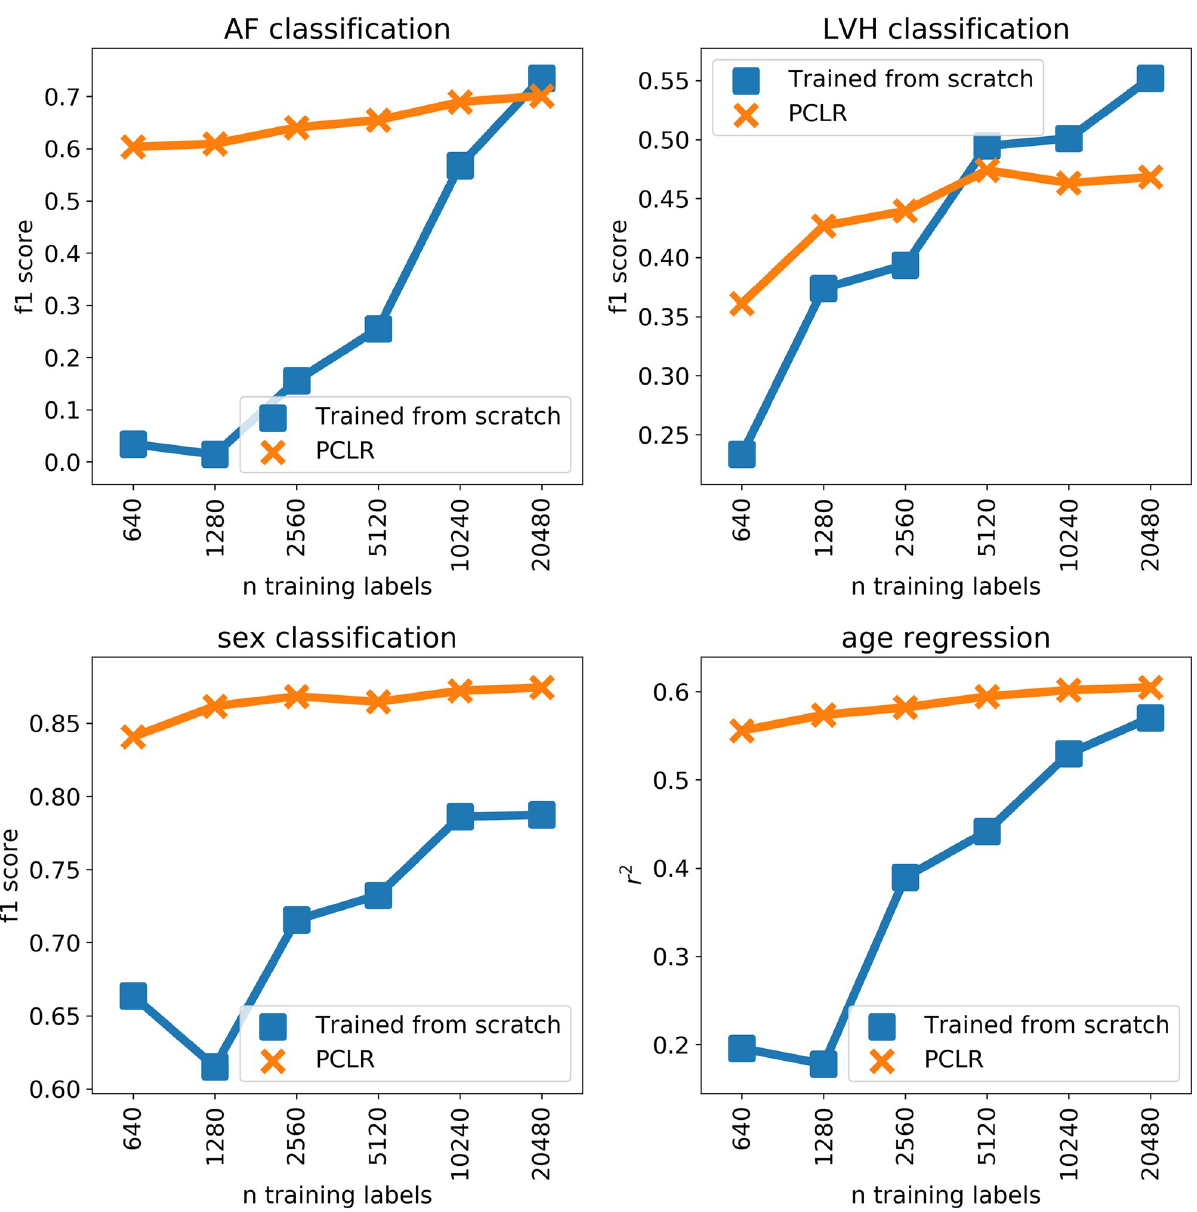
Fig 7. Results of training from scratch vs. linear models trained on